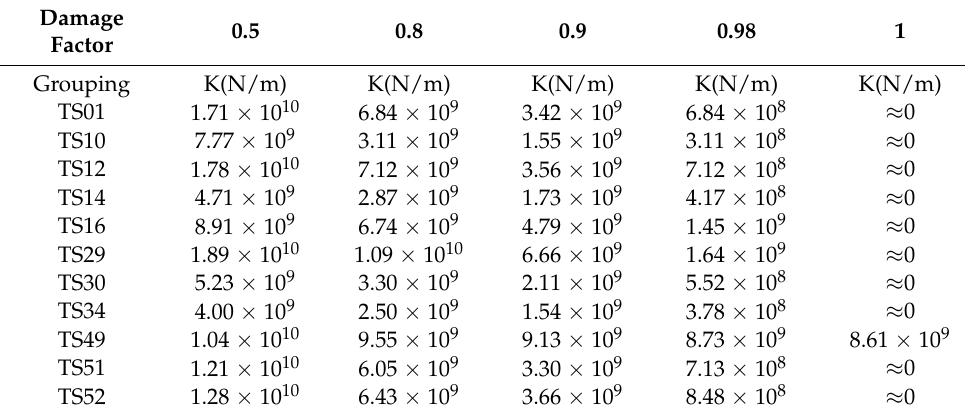
Figure 17 shows the vertical displacement of the roof slab of the cave from left to right when the damage factor was 0.5, 0.8, 0.9, and complete damage. With the increase of the damage of the cracked slate, the uneven settlement of the roof plate of the cave occurred, and the maximum settlement position was shifted from the central area to the left front of the cave, which had a significant effect on the force deformation and stability of the roof plate of the cave. According to the numerical simulation results, the vertical displacement curve of each measurement point with the damage factor was made in the horizontal coordinate of the cracked stone damage factor (Figure 18a). The horizontal displacement in the x and y directions of the two pairs of measurement points above and below the L6 crack was decomposed and differentiated along the vertical direction of the L6 crack. The change curve of the width of the L6 crack above and below the damage factor was